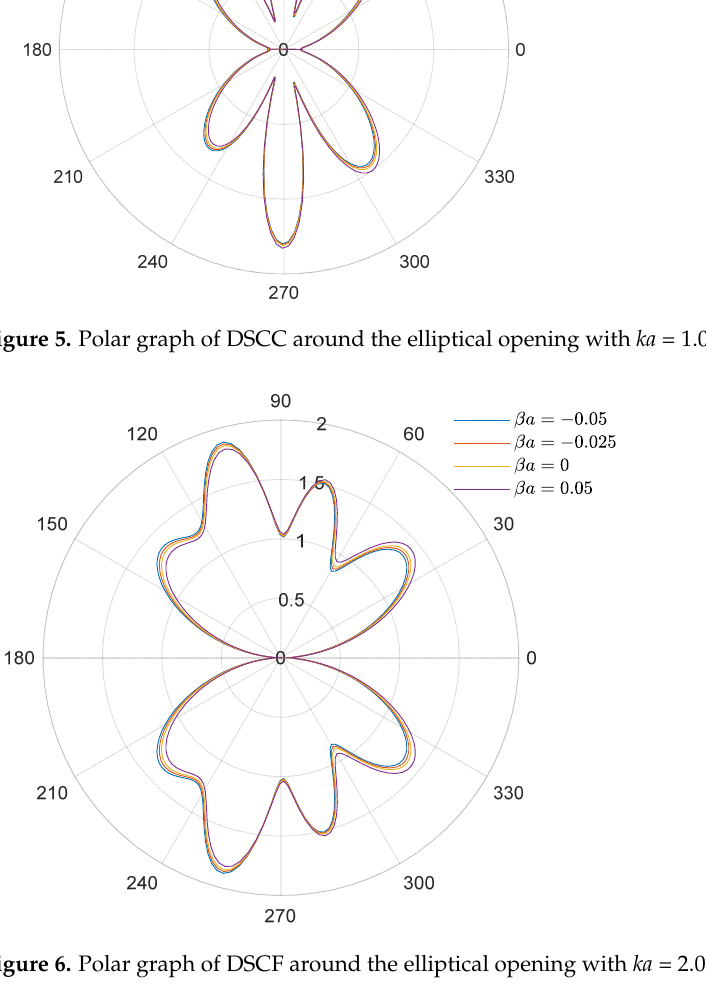
Figure 6. Polar graph of DSCF around the elliptical opening with ka = 2.0 and m = 1/6.